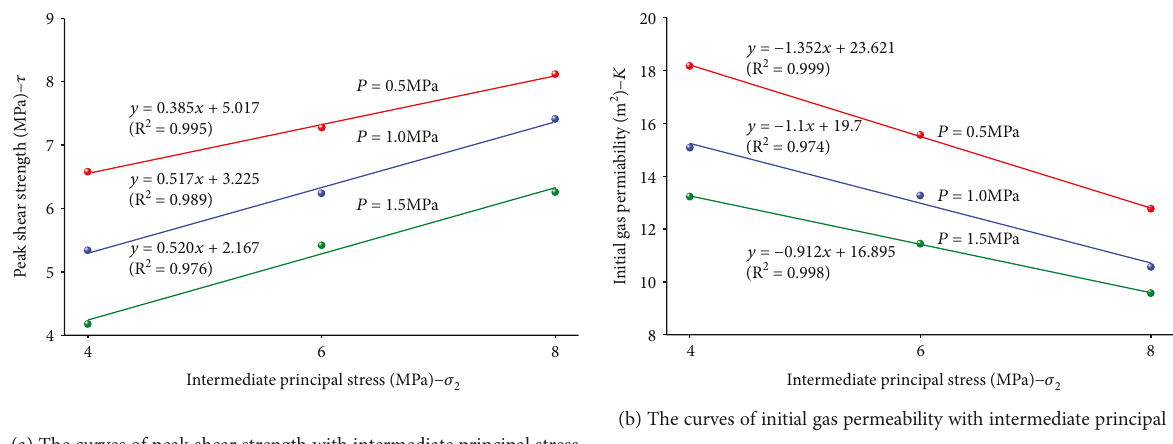
Figure 11: The correlation curves of peak shear strength and initial gas permeability with intermediate principal stress under di ff erent gas pressure conditions.